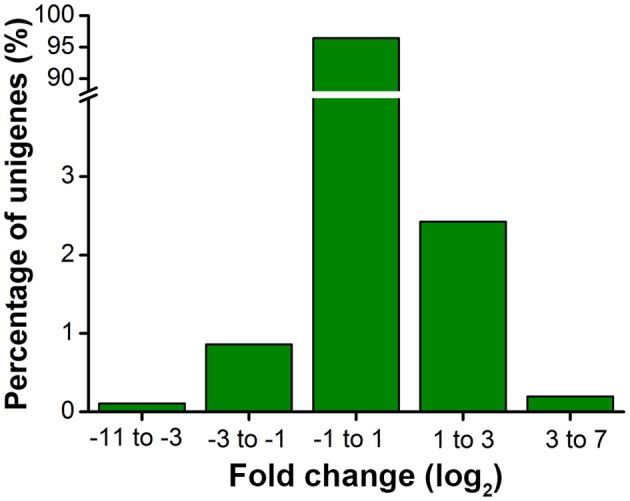
Fold change distribution of green peach aphid unigenes between nymphs and adults. The x-axis shows the fold change (log2 ratio) of gene expression in nymphs compared to adults. |Log2| values of 2244 unigenes are higher than 1, indicating potential importance during developmental transition.